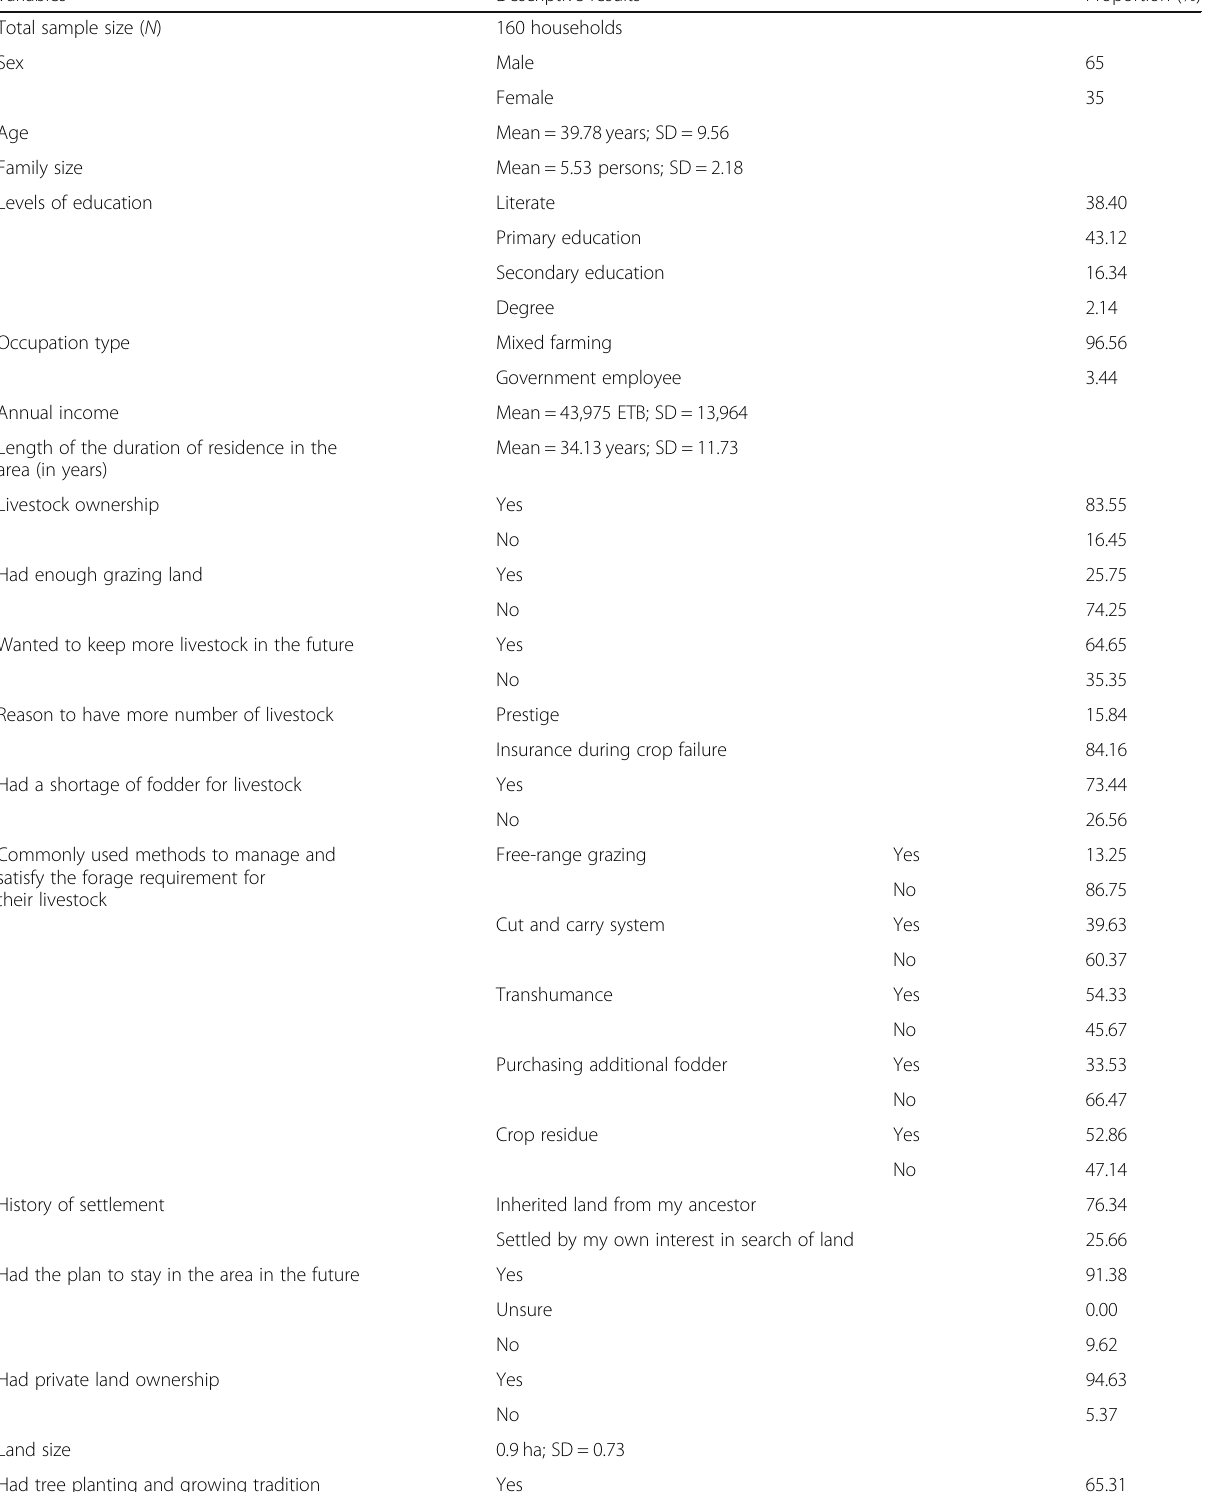
Table 1 Socioeconomic characteristics and descriptive